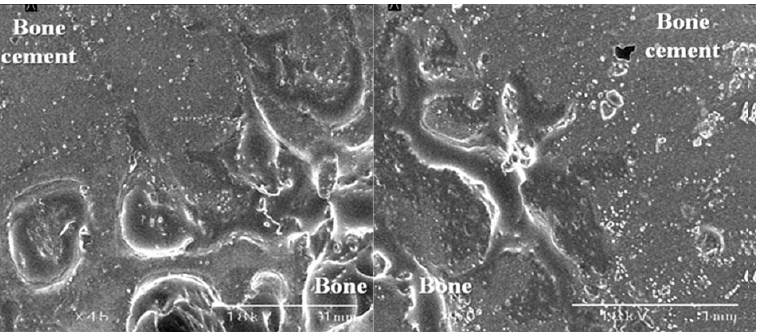
Figure 7. Scanning electron microscopy of the interface between the bone and bone cement. There was no gap between the bone and bone cement in all four pairs of the femoral specimens.